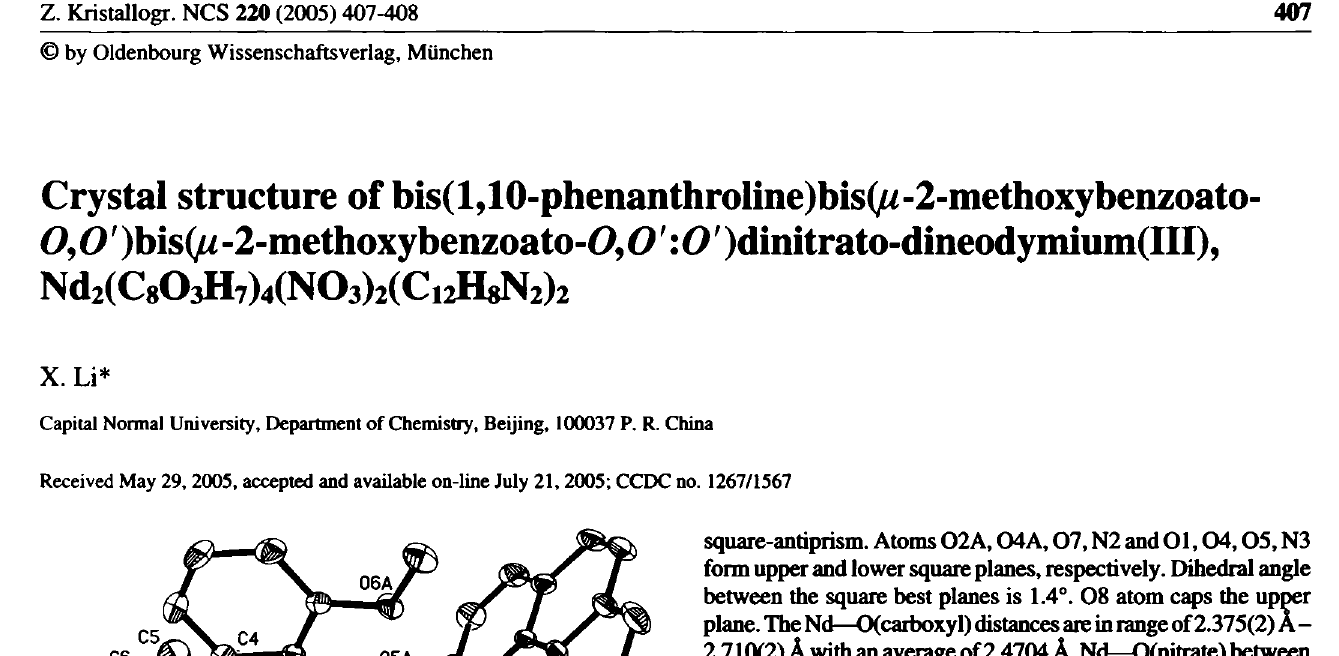
Table 1. Data collection and handling.